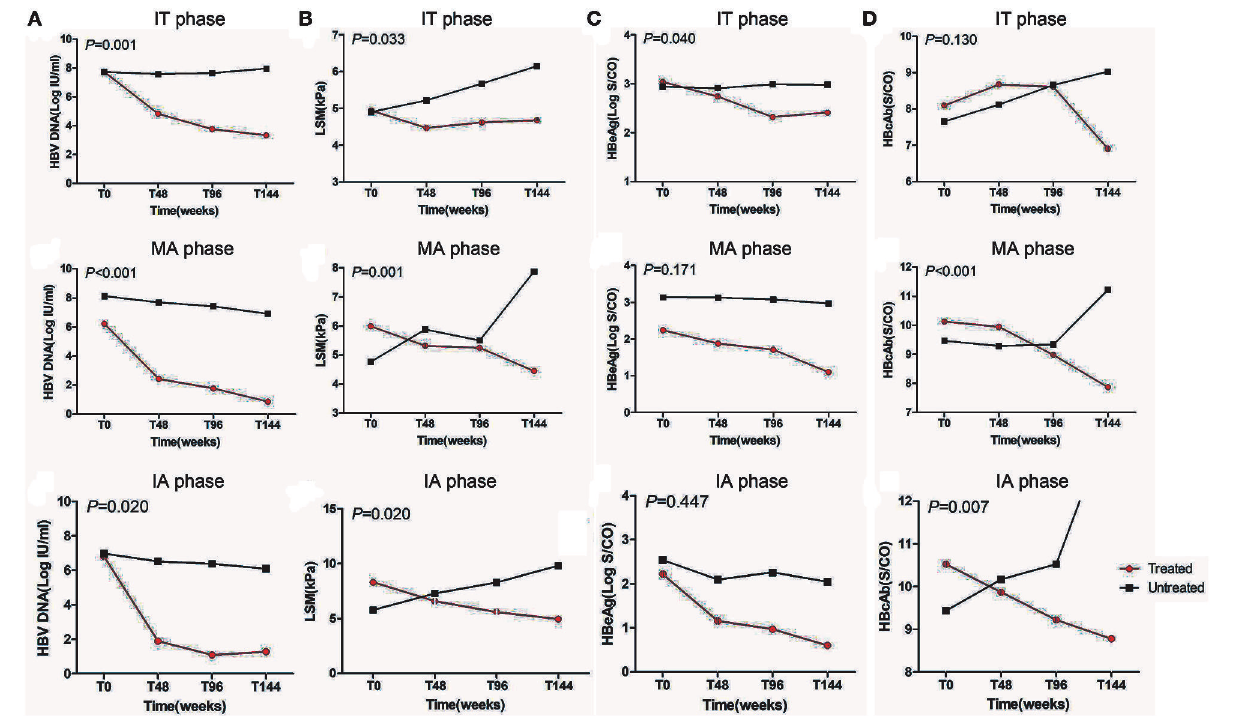
showed a significant decrease in HBeAg levels compared with the corresponding untreated group ( P < 0.05, Figure 2C ). In the MA and IA phases, there was a significant decrease in anti-HBc level in the treated set compared with untreated patients ( P < 0.05, Figure 2D